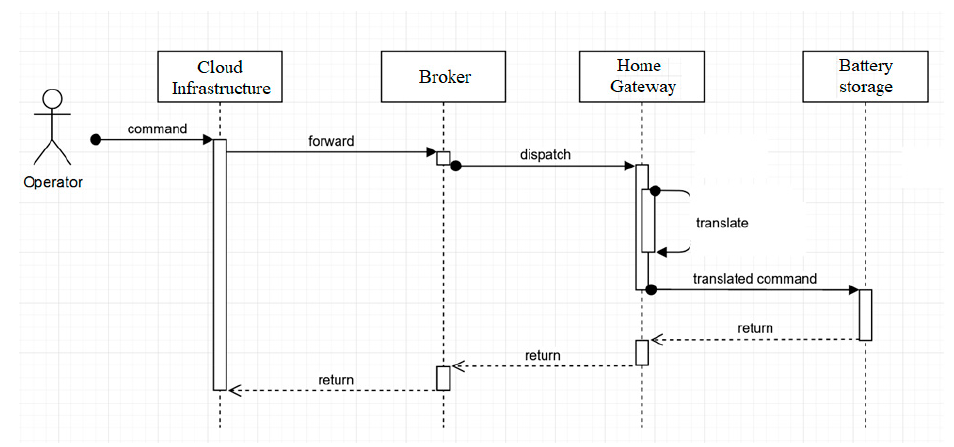
Figure 6. Data fl ow for sending commands to control the ba tt ery storage operation.